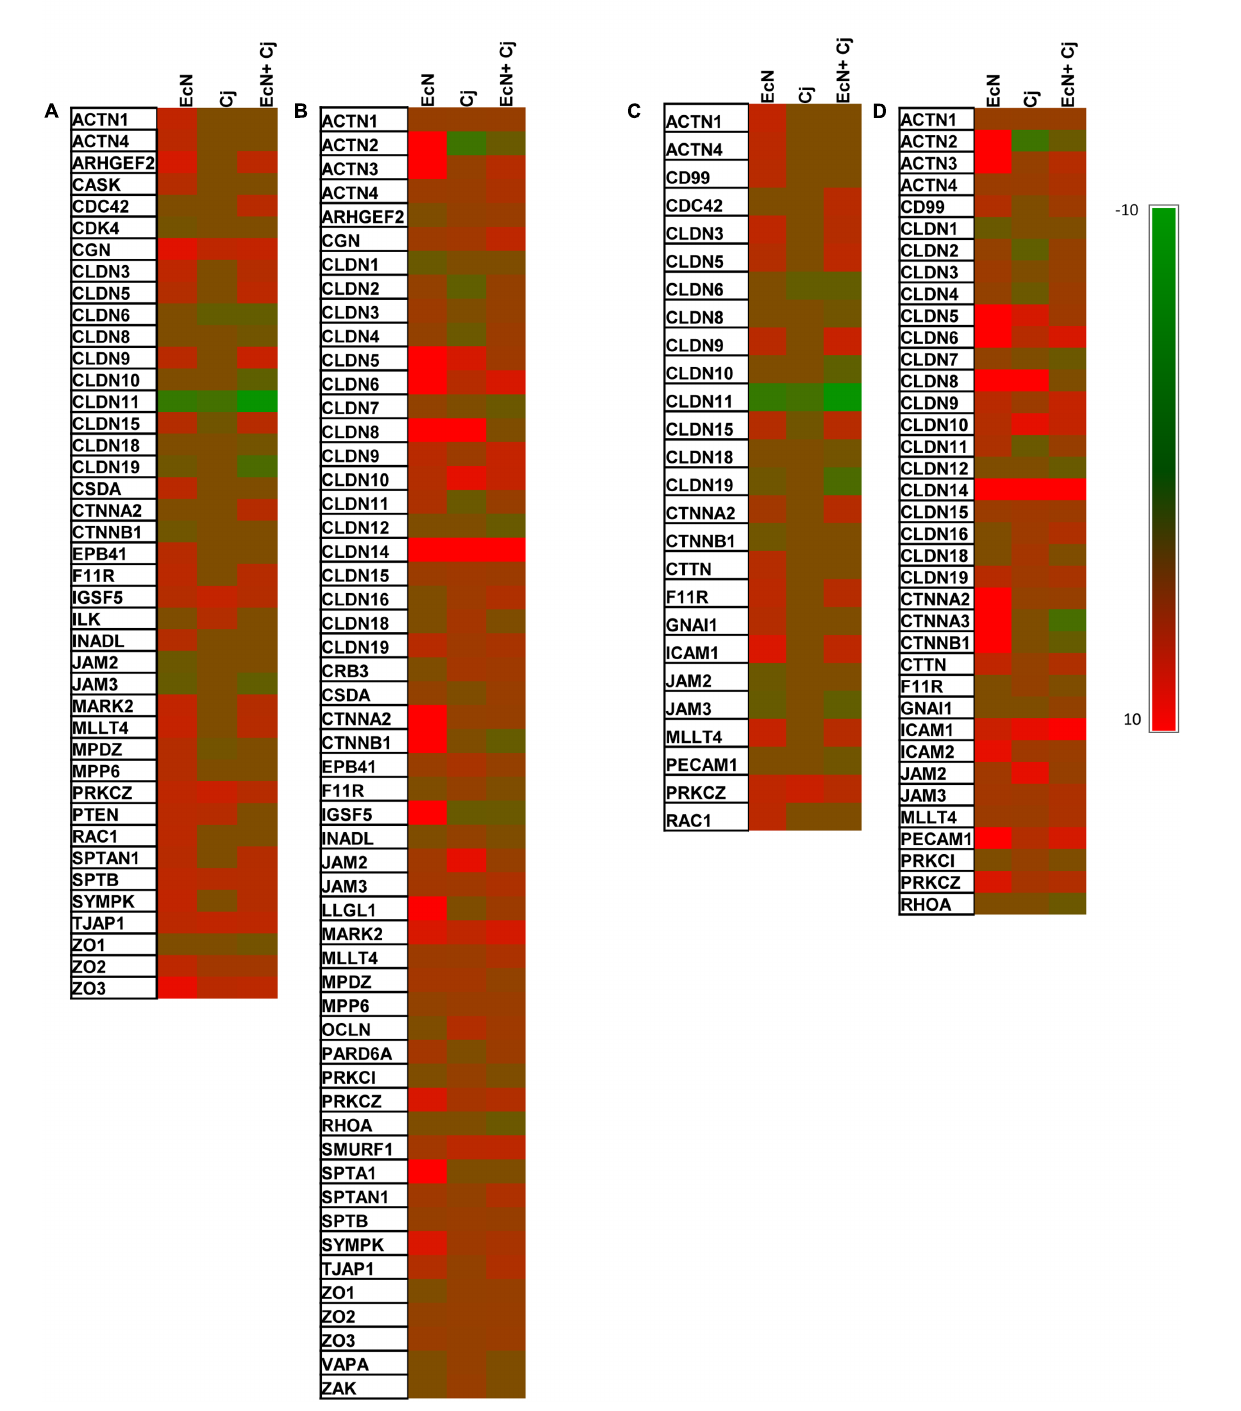
Frontiers in Microbiology |